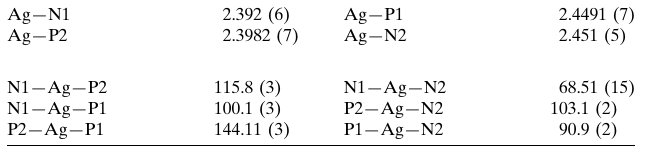
Selected geometric parameters (A˚ , (cid:1)